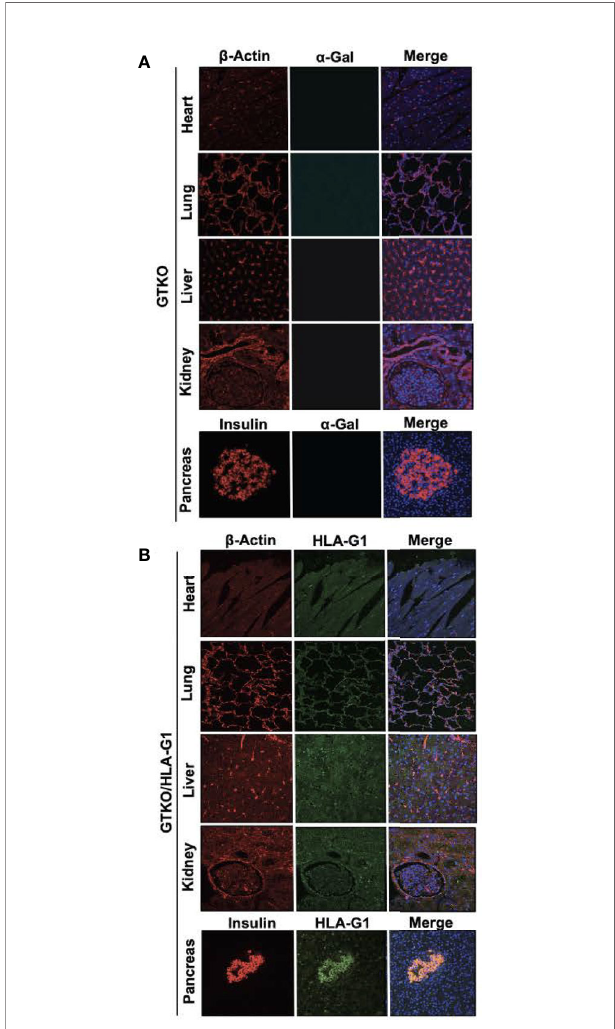
FIGURE 3 | Confocal microscopy demonstrating physical characterization of genetically engineered tissues. (A) GTKO expression on heart, lung, liver, kidney and pancreas labelled with Rabbit mAb to b-actin [13E5] (Cell Signaling Technology; #4970S) and tagged to Goat anti-rabbit IgG AF 488 (Invitrogen; A11008), Isolectin GS-IB 4 AF 647 Conjugate (Life Technologies; I32450) and DAPI. (B) GTKO/HLA-G1 on tissues was labelled using Mouse HLA-G monoclonal Antibody [87G] (Invitrogen; MA1-10356) and tagged to Goat anti-mouse IgG AF 555 (Invitrogen; A32727). Goat anti-mouse IgG1 Fc Secondary Antibody FITC (Invitrogen; 31547) was used as an isotype control for 87G. Pancreas section were labelled with Polyclonal Guinea Pig Anti- insulin (Dako; A0564) tagged to Donkey Anti-guinea pig IgG (H+L) AF 647 (Jackson Immuno Research; 706-606-148) instead of b-actin and DAPI. All sections were imaged using the 10X, 20X and 40X objective on Olympus Fluoview 3000 inverted confocal